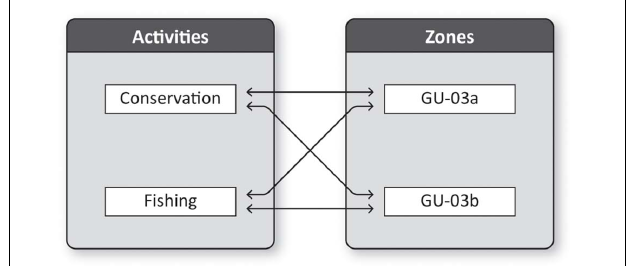
FIGURE 3 | Multicriteria model with feedback implemented through ANP (analytical network process) to analyze a change in activity allocation depending on the level of incidental